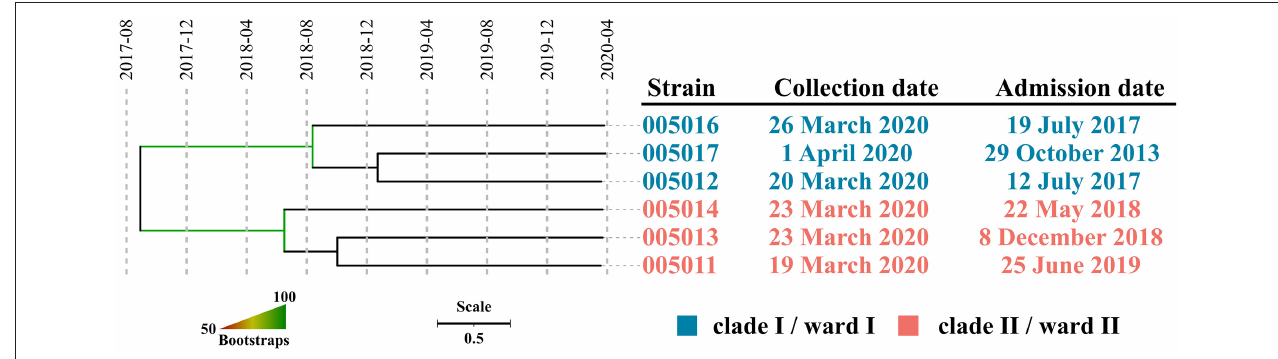
FIGURE 2 | The dated phylogeny of ST5 MRSA isolated around March 2020. Strains within well-separated clades were labeled in either blue (clade I) or red (clade II). Branch supports were colored in gradients.